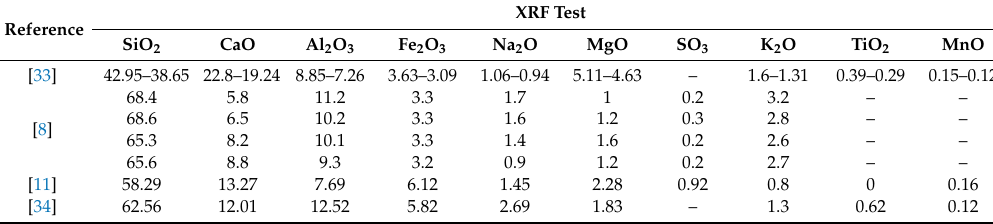
Table 2. Summary of the literature review on the results of the XRF